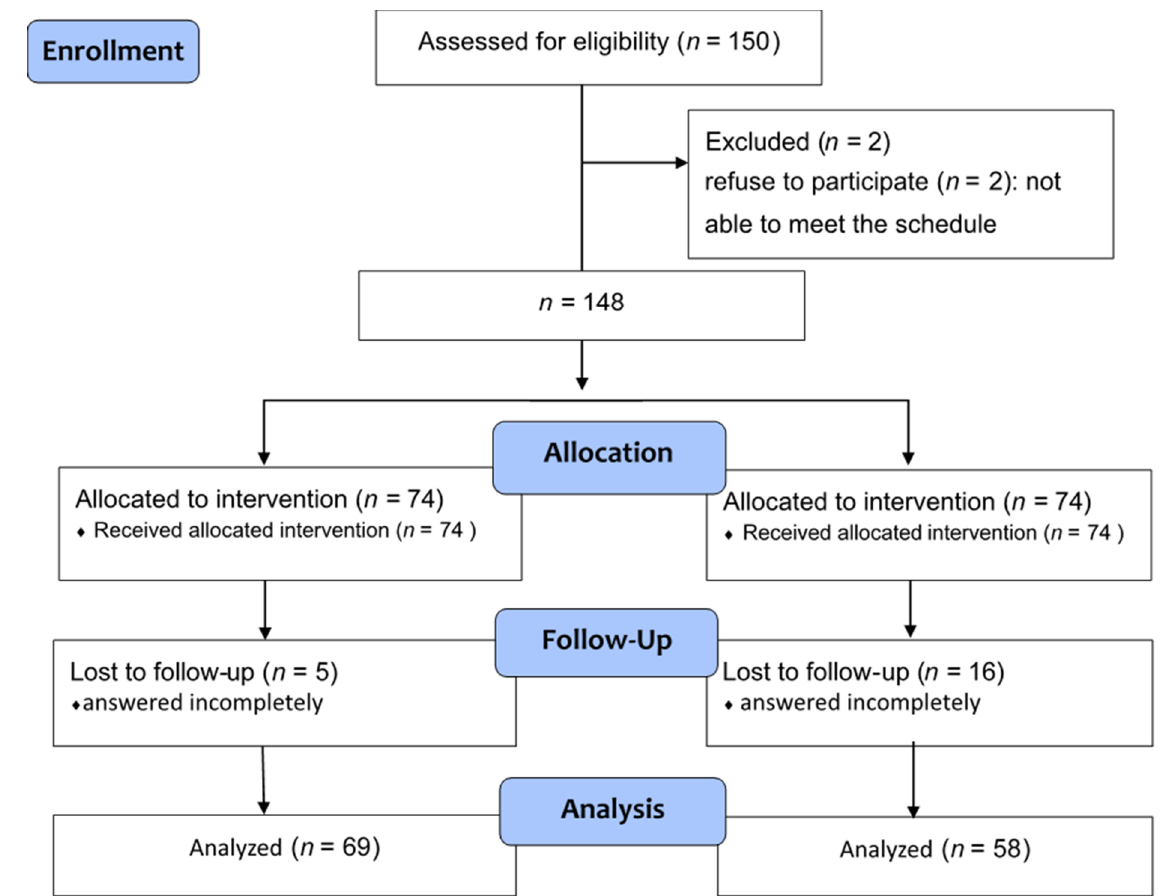
Figure 1. Participant recruitment and follow-up